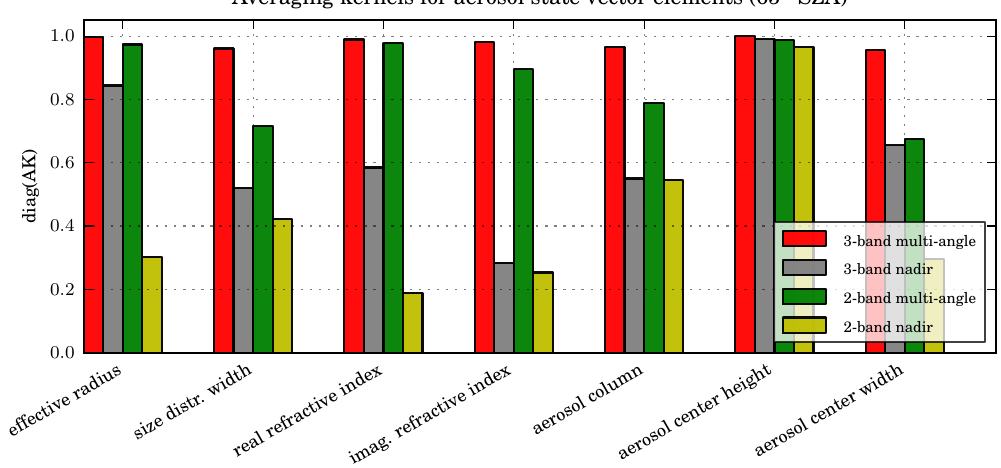
Fig. 6. Averaging kernel diagonal elements related to aerosols in the large solar zenith angle case ( ≈ 65 ◦ ). Otherwise, same as Fig.